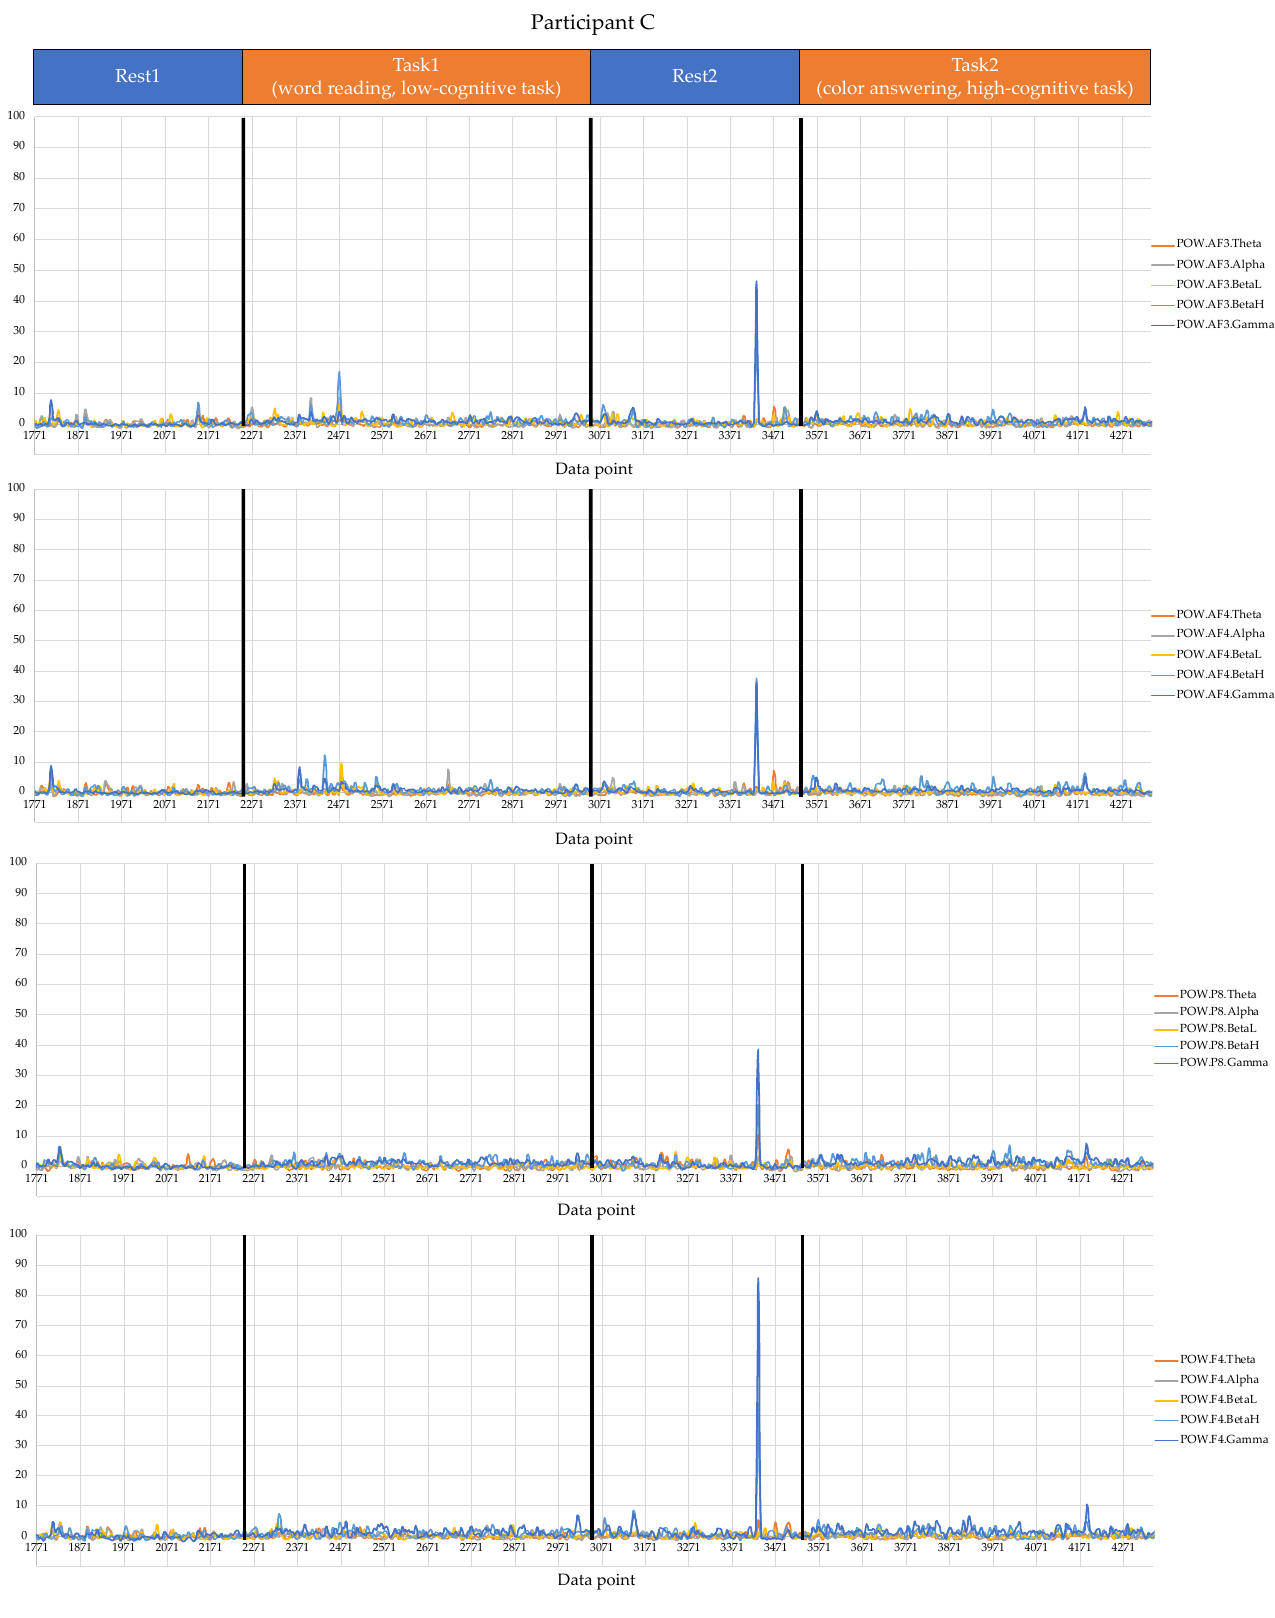
Figure 6. Raw waveforms used to calculate the EEG indexes of Participant C. (Note that the wave- forms include only EEG channels with significant correlations (AF3, AF4, P8, and F4), as summarized in Table 17.).